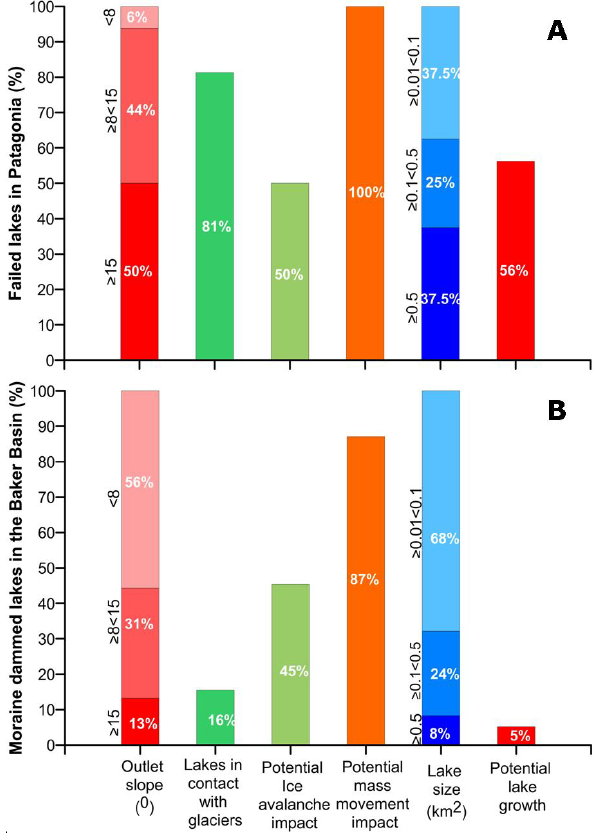
Figure 10. (a) Characteristics of 16 failed moraine-dammed lakes in Patagonia and (b) characteristics of 386 moraine-dammed lakes in the Baker Basin.